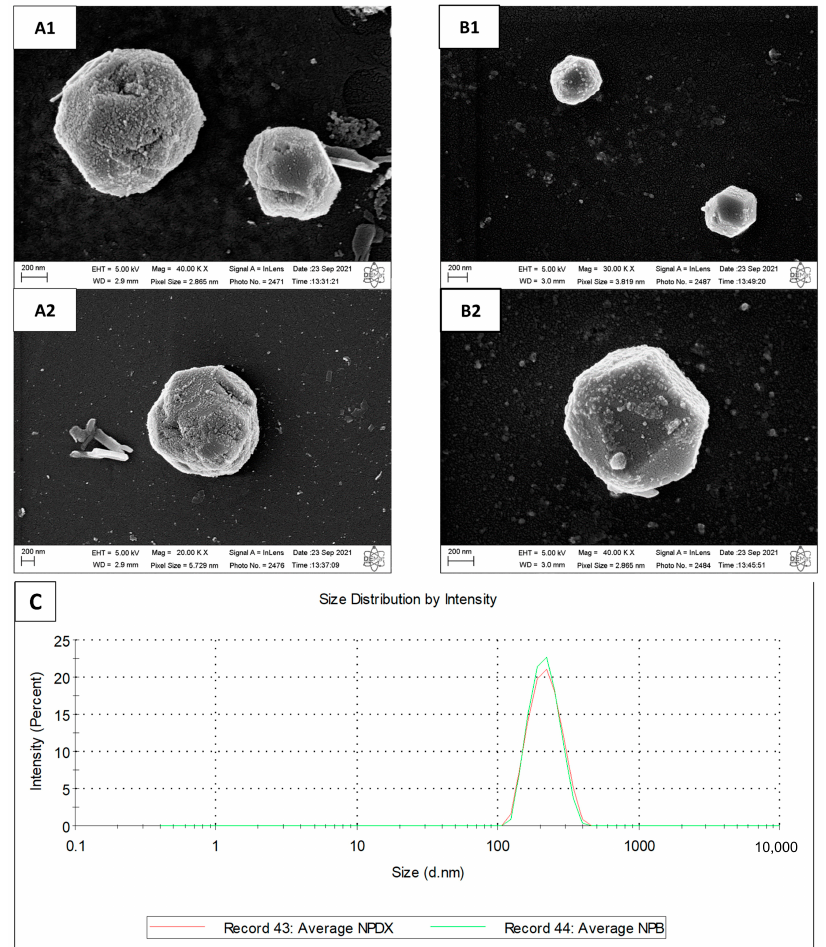
Figure 9. Scanning electron microscopy of ( A1 , A2 ) empty nanoparticles and ( B1 , B2 ) doxycycline- loaded nanoparticles. ( C ) Particle size distribution by percentage of intensity for empty nanoparticles (NPB) and doxycycline-loaded nanoparticles